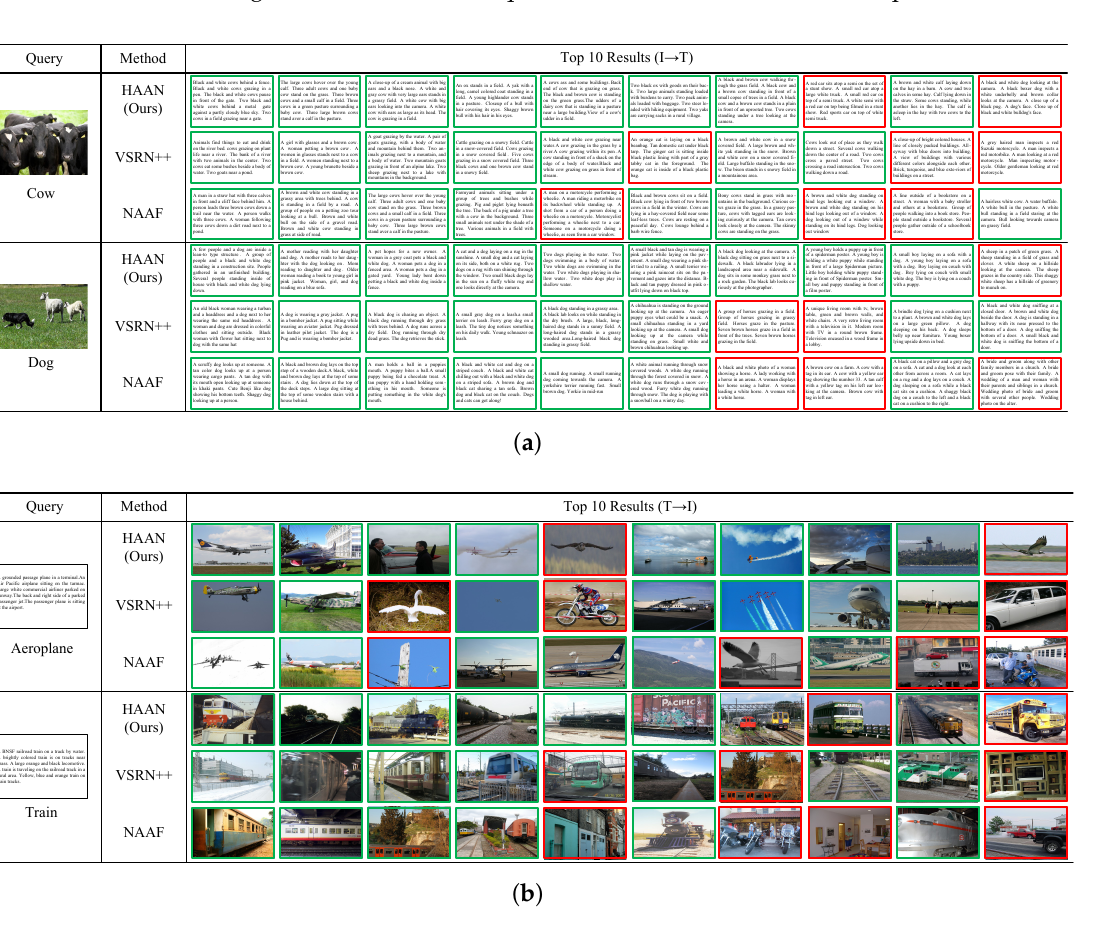
Figure 9. Example results for I 2 T and T 2 I on Pascal Sentence dataset using HAAN, VSRN++ and NAAF. Specifically, the green border indicates a correct search result, and the red border indicates an incorrect search result. ( a ) Examples of I 2 T retrieval results on Pascal Sentence dataset; ( b ) Examples of T 2 I retrieval results on Pascal Sentence